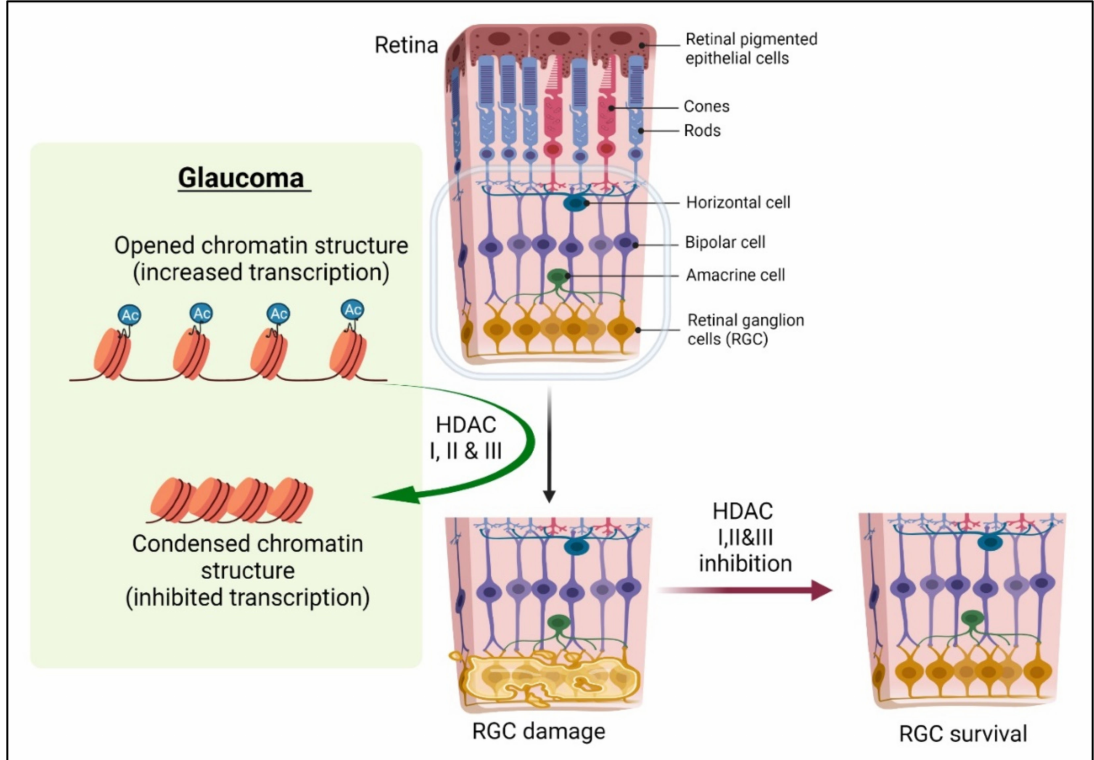
Figure 2. HDAC inhibitors rescue RGCs by modulating the histone acetylation levels. HDAC families I, II, and III are known to upregulate significantly in glaucoma models [64]. Blocking HDAC activity using inhibitors offers significant neuroprotection, including enhanced RGC protection. HDAC activity inhibition reprograms the chromatin structure to a pro-translational configuration which occurs through modulation of factors such as p53, CREB-binding protein/p300 (CBP/p300), and the p300-CBP-associated factor (P/CAF), which facilitate neuroprotection, etc. [67,68]. Ac: acetyl